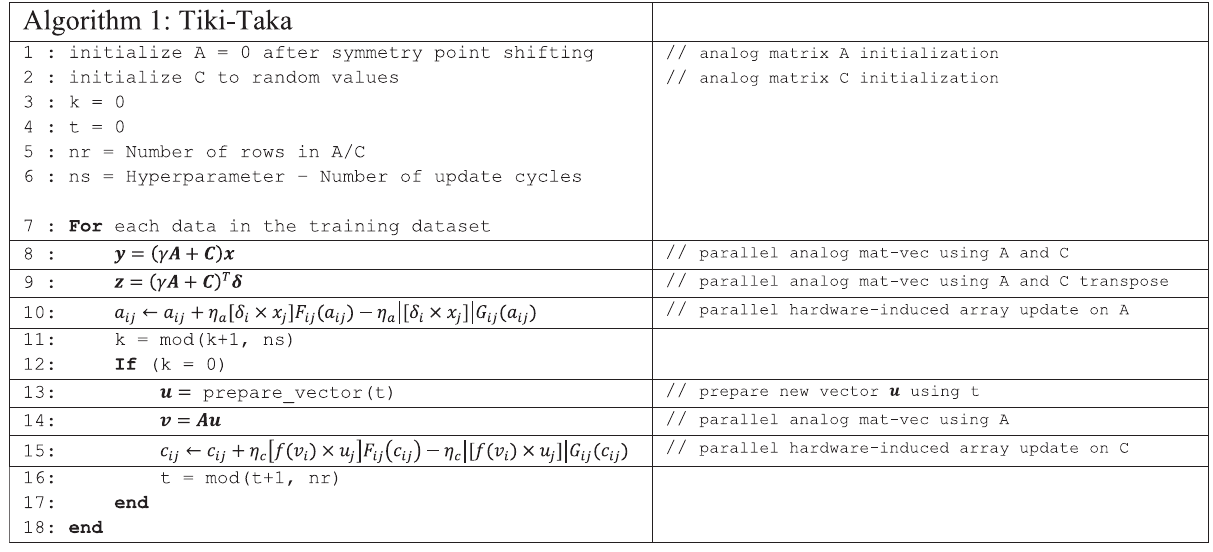
Algorithm 2 outlines the details of the TTv2 algorithm.